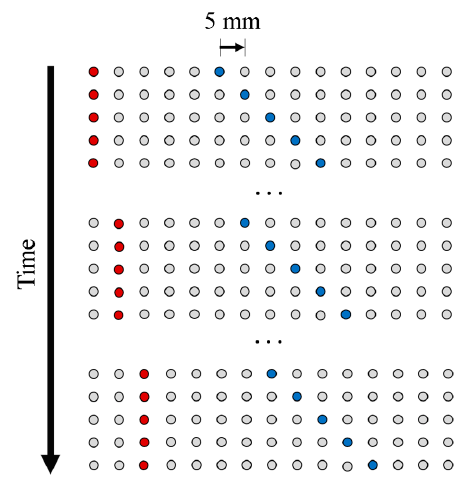
Figure 3. Schema of data acquisition. In this simplified schema realized for explanation purposes, 15 antenna positions are considered (instead of the 28 positions of the real array). Red and blue dots represent transmitting and receiving antennas, respectively.